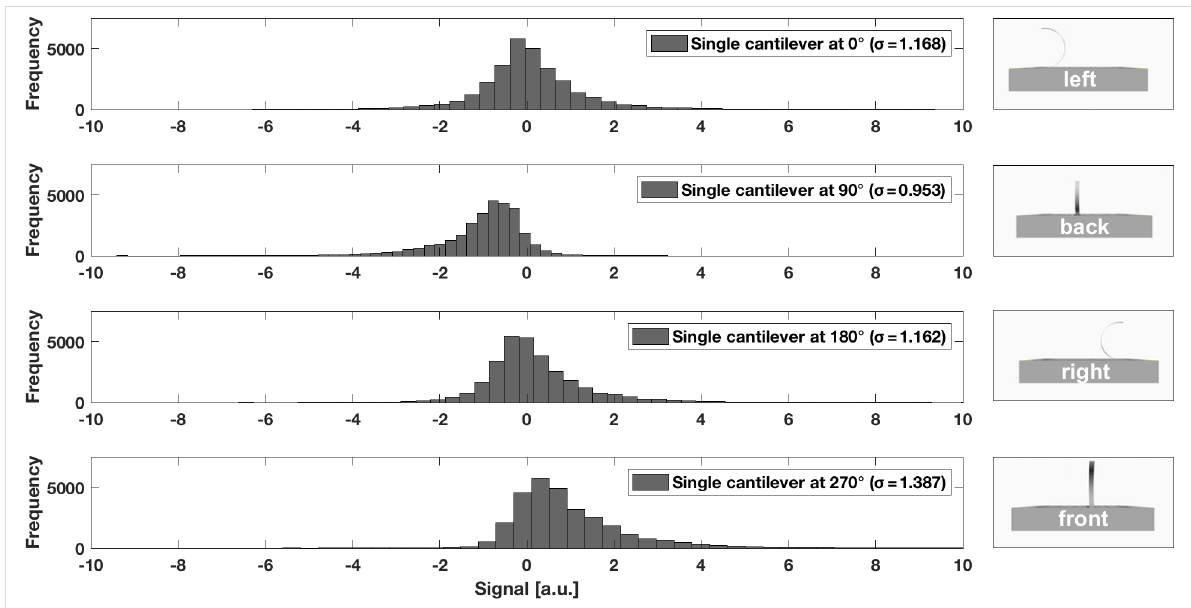
Figure 10: Average mean distribution of 30,000 measurement values for the single cantilever at rotation angles 0°, 90°, 180°, and 270°. Standard de- viations ( σ ) are listed in the legend.